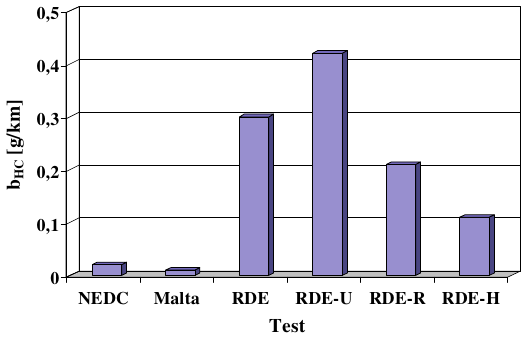
Fig. 9. Mean hydrocarbons road emissions – b HC in each of the test